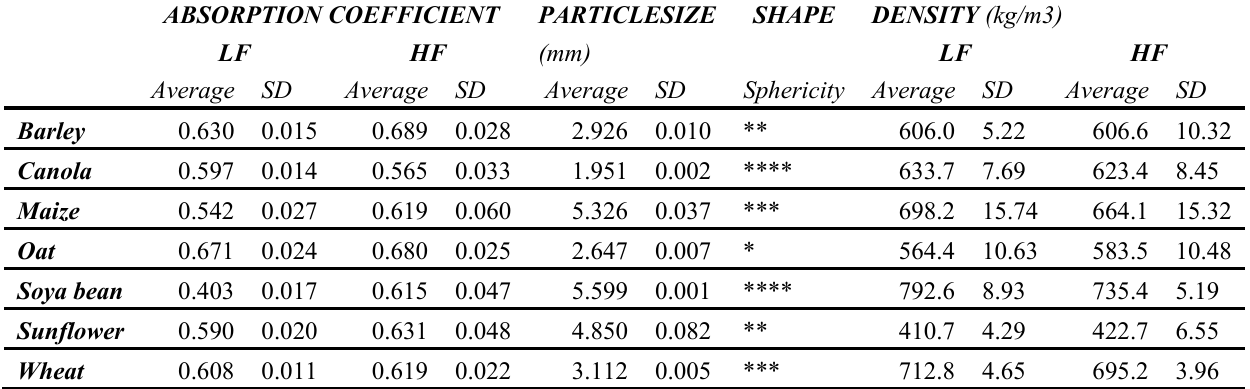
Table 1. Absorption coefficient average and standard deviation (SD), particle size, sphericity and samples density of the different seed types at the low frequency range (LF) and the high frequency range (HF). Note that the higher number of asterisks, the more spherical is the